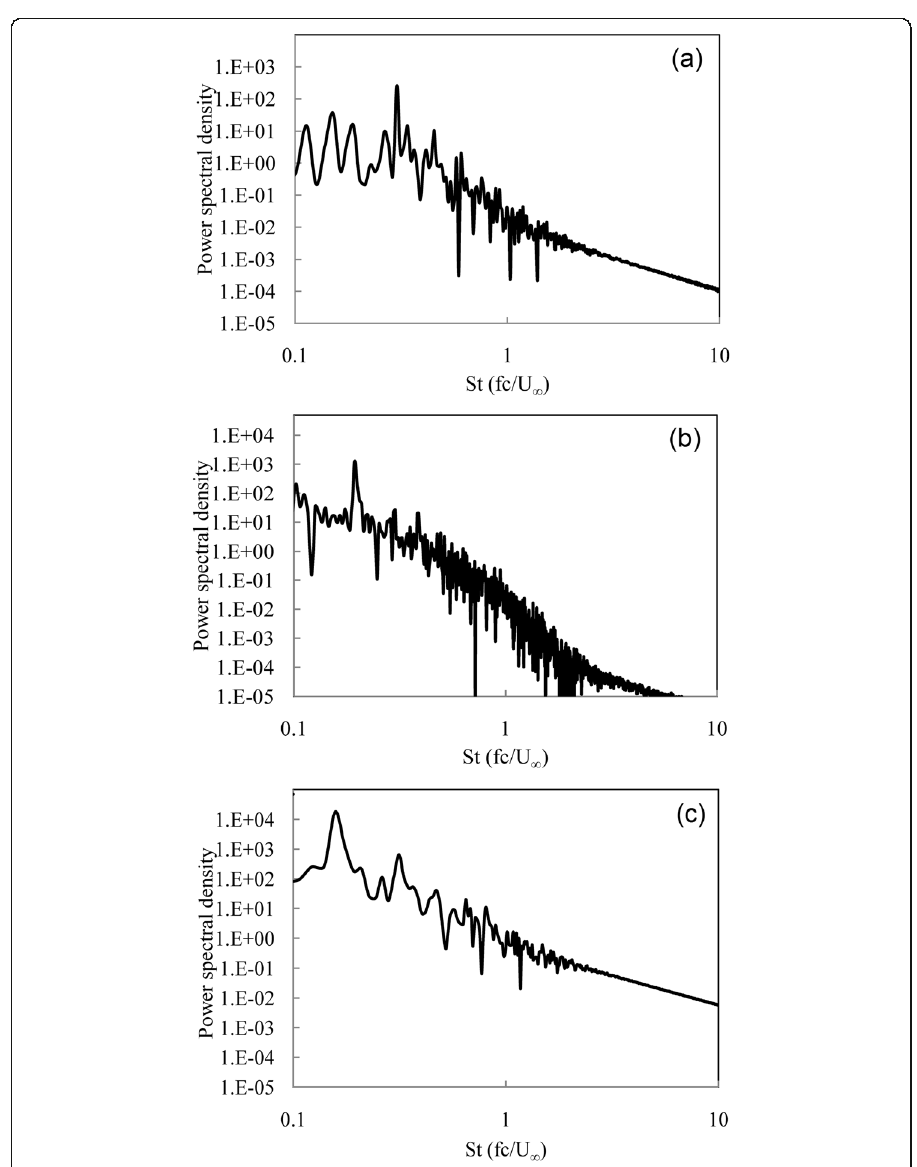
Table 4 Strouhal number comparison obtained from experiments and current LES Inclination angle ( α )